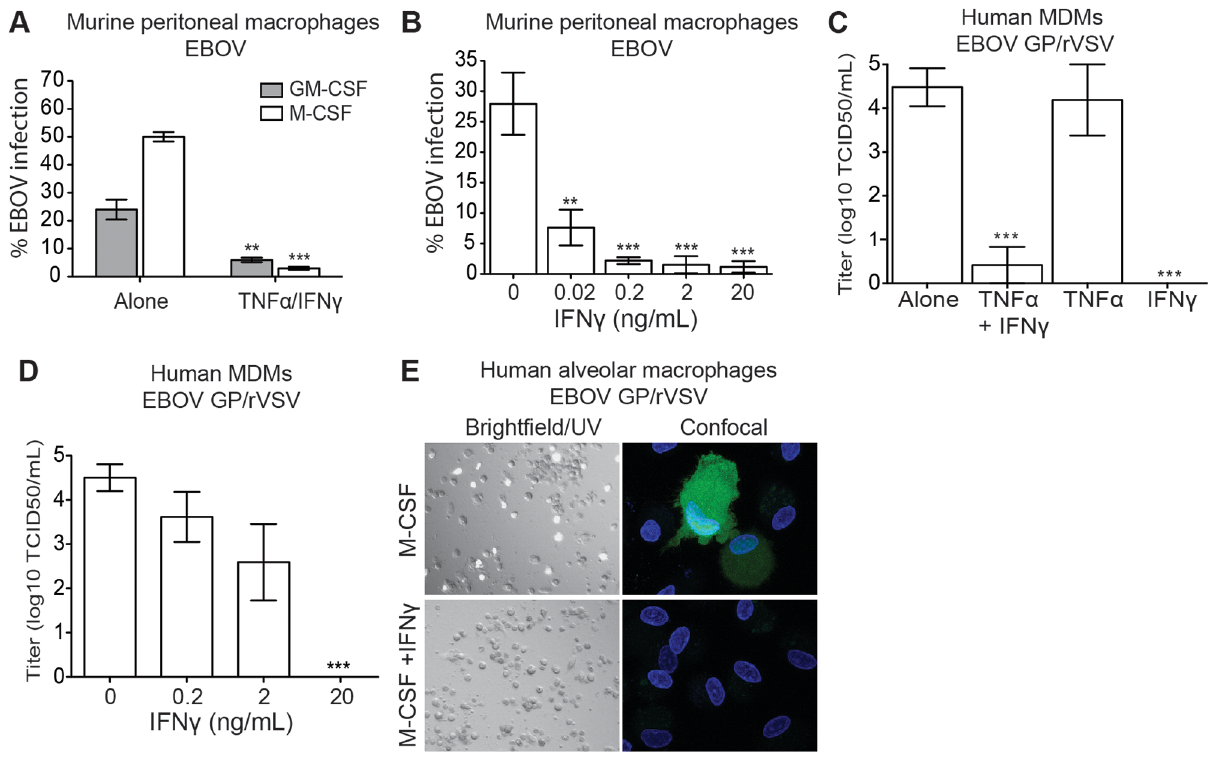
Fig 1. IFN γ -treated macrophages are resistant to EBOV infection. (A) IFN γ /TNF α treatment inhibits EBOV infection of BALB/c peritoneal macrophages. Cultures maintained in media containing GM-CSF or M-CSF were treated with murine IFN γ /TNF α 24 hours prior to EBOV-GFP infection (MOI = 0.05 in Vero E6 cells). Shown are the percent GFP positive cells at 24 hours following infection. (B) IFN γ inhibits EBOV in a dose-dependent manner. BALB/c peritoneal macrophages were infected with EBOV-GFP (MOI = 0.05) 24 hours following IFN γ treatment. (C) IFN γ , but not TNF α , treatment of M-CSF differentiated hMDM cultures inhibits EBOV GP/rVSV infection. Virus titers were determined by end-point dilution on hMDMs from 4 independent donors. (D) Dose response curve of IFN γ inhibition of EBOV GP/rVSV infection of M-CSF-treated hMDMs. (E) IFN γ inhibits EBOV GP/rVSV infection in M-CSF cultured human alveolar macrophages. Left, bright field/UV (magnification: 10X). Right, confocal images (magnification: 100X). All infections were assessed 24 hours following addition of virus. Data are shown as means ± s.e.m. Significance was determined by Student ’ s t-test compared to no IFN γ control, ** p < 0.01, *** p < 0.001.